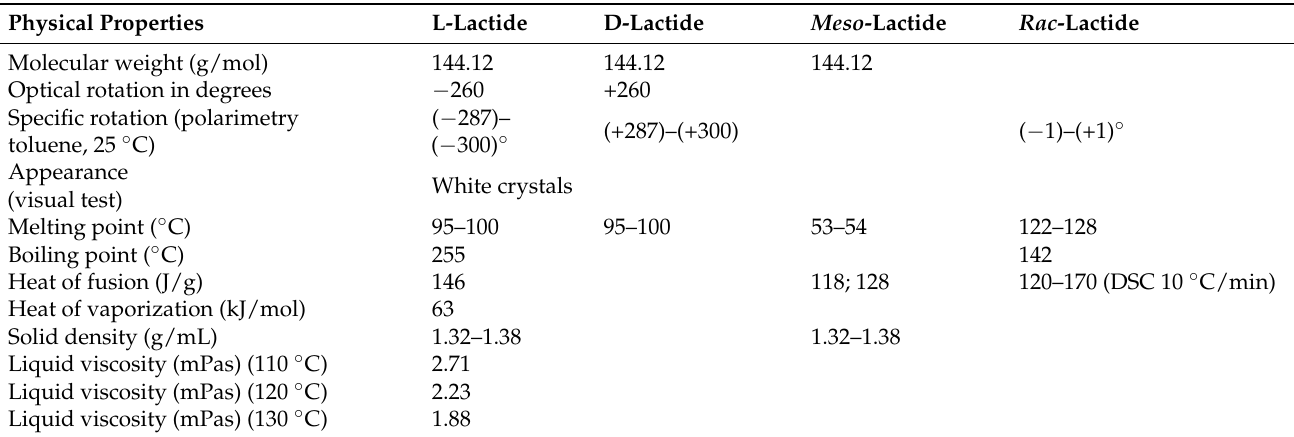
Table 2. Physical properties of the